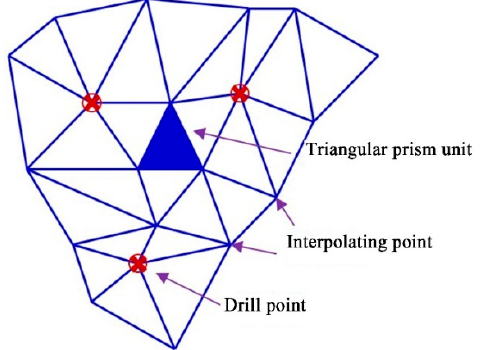
Figure 34. Interpolation network diagram.